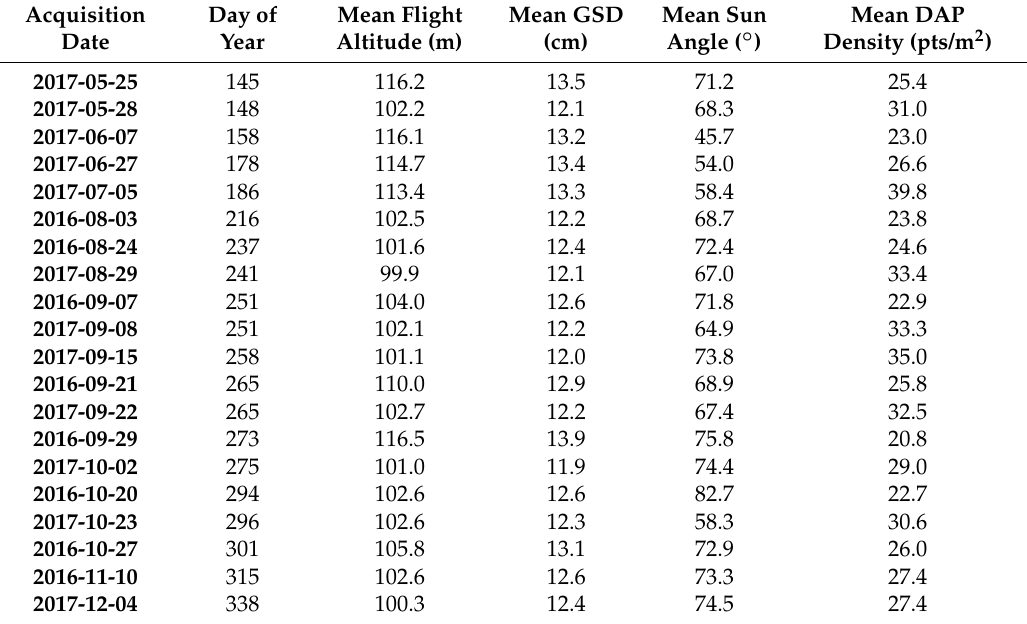
Table 1. Imagery acquisition dates and corresponding mean flight altitude (above ground), mean ground sample distance (GSD), mean sun angle, and mean digital aerial photogrammetry (DAP) point